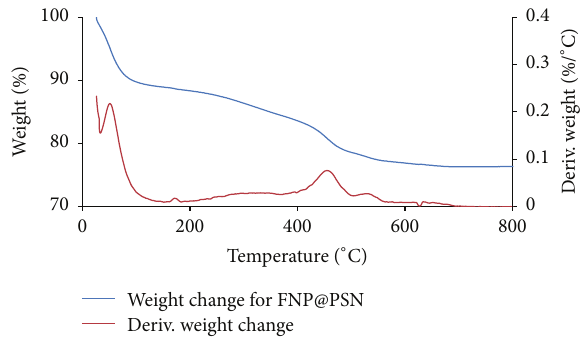
Figure 3: Thermogravimetric analysis of